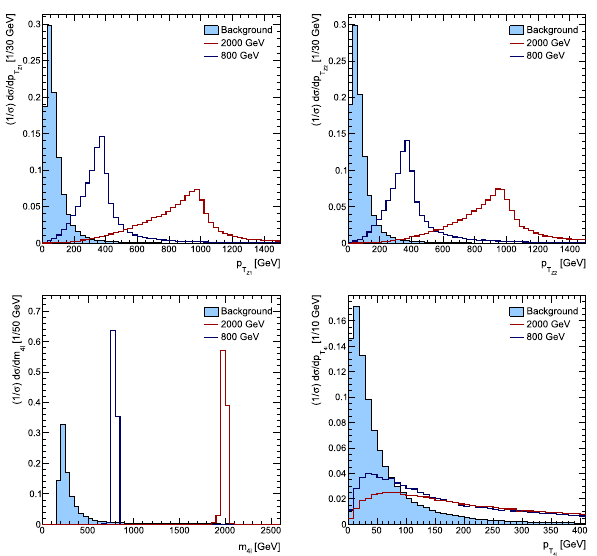
Fig. 11 Normalized differential cross sections as a function of the transverse momentum of Z 1 boson ( a ) Z 2 boson ( b ), and the invari- ant mass ( c ) and transverse momentum ( d ) of the four-lepton system = 2000 GeV (red line), 800 GeV (blue line) and background for m h √ 2 s = 100 TeV (blue solid) at